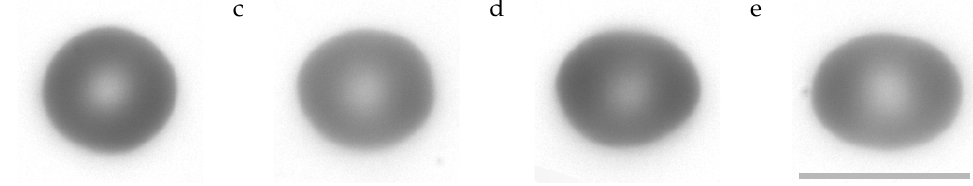
Figure 9. Examples of donor 4 showing the ranges of aspect ratio and <LFA>. Their values are ( a ): 1.0, 1.003. ( b ): 1.073, 0.938. ( c ): 1.146, 0.862. ( d ): 1.219, 0.804. ( e ): 1.291, 0.746. The images are rotated to make the major axis horizontal. The scale bar indicates 10µm.